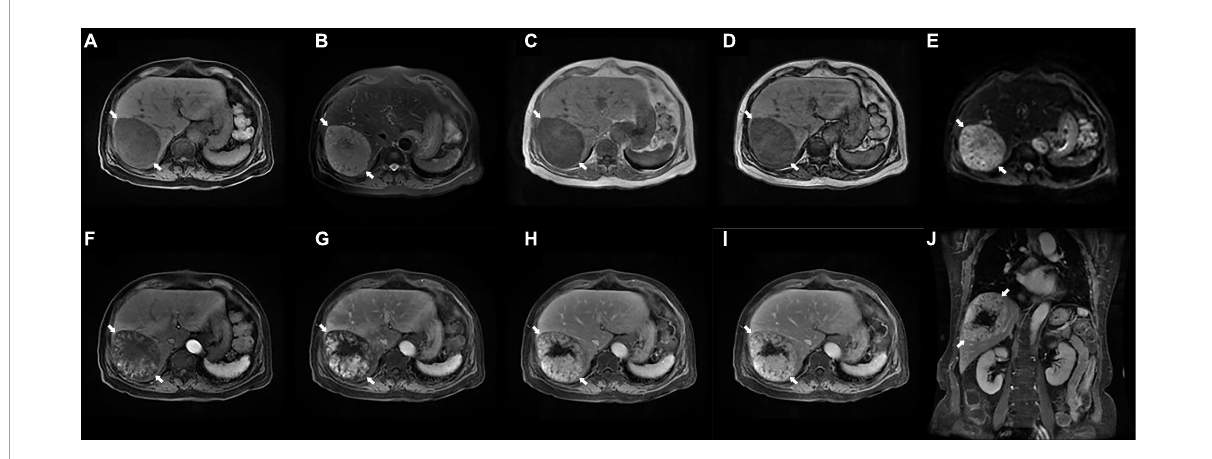
FIGURE1 Preoperative enhanced magnetic resonance imaging (MRI) examination. (A) T1WI shows an ovalshaped hypointense lesion with clear border in the right lobe of the liver (arrows, 94 × 74 mm). (B) Fat-suppressed T2WI shows a slightly hyperintense lesions (arrows). (C,D) The in-phase (C) and out-of-phase (D) of T1WI demonstrates hypointense speckled signals within the mass (arrows). (E) DWI shows a hyperintense lesions (arrows). (F–J) Enhanced MRI scans showed progressive enhancement of the lesion (arrows) on the early (F) and late (G) arterial phase, portal venous phase (H) , delayed phase (I) , and coronal view (J) , while no enhancement was seen in the necrotic region. MRI, magnetic resonance imaging; T1WI, T1 weighted image; T2WI, T2 weighted image; DWI, diffusion weighted